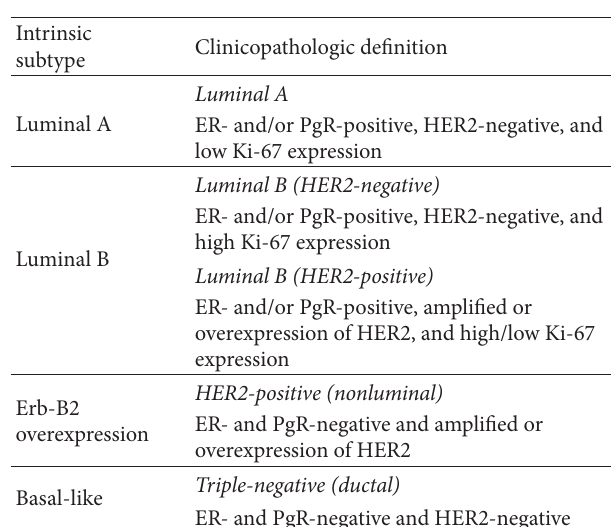
Table 1: Surrogate definitions of the intrinsic subtypes of breast